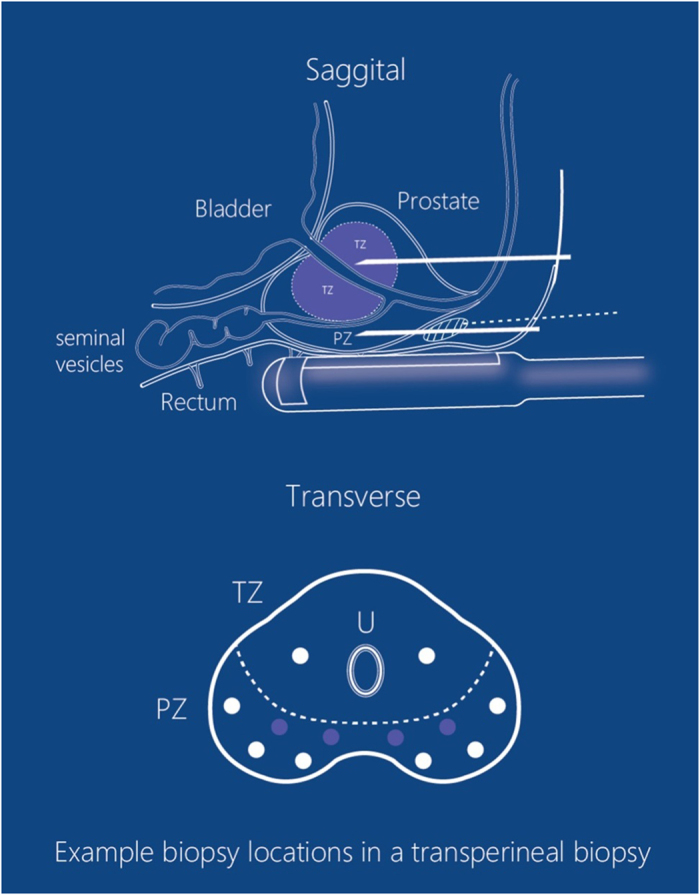
The protocol of TPBx. On sagittal section, both peripheral zone (PZ) and transition zone (TZ) biopsy are performed transperineally.The depots of PPNB are apical (in the white circle with diagonals), and the routes of administration are transperineal (white dotted lines). On transverse section, for 8-core TPBx, six cores are sampled from the PZ and the other two are from the TZ (marked as white circles). For 12-core TPBx, four more cores are sampled from the PZ (marked as violet circles).